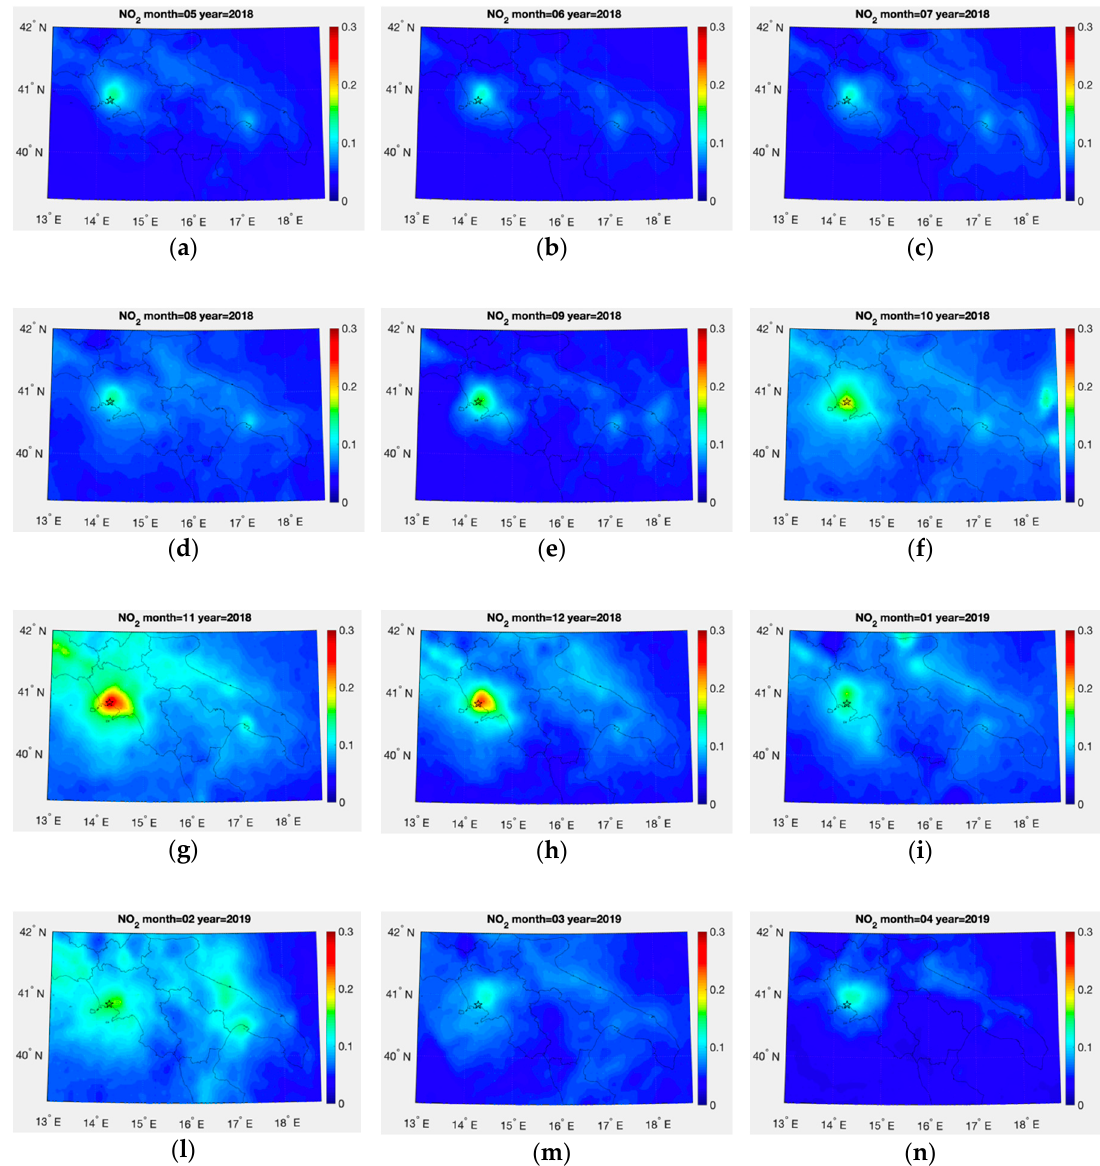
Figure 14. Monthly average maps of Level 3 NO 2 tropospheric column (Dobson) over the Southern Italy area during the period between May 2018 and April 2019. In particular, May ( a ), June ( b ), July ( c ), August ( d ), September ( e ), October ( f ), November ( g ), December ( h ) 2018 and January ( i ), February ( l ), March ( m ), April ( n ) 2019. The star indicates the city of Naples.